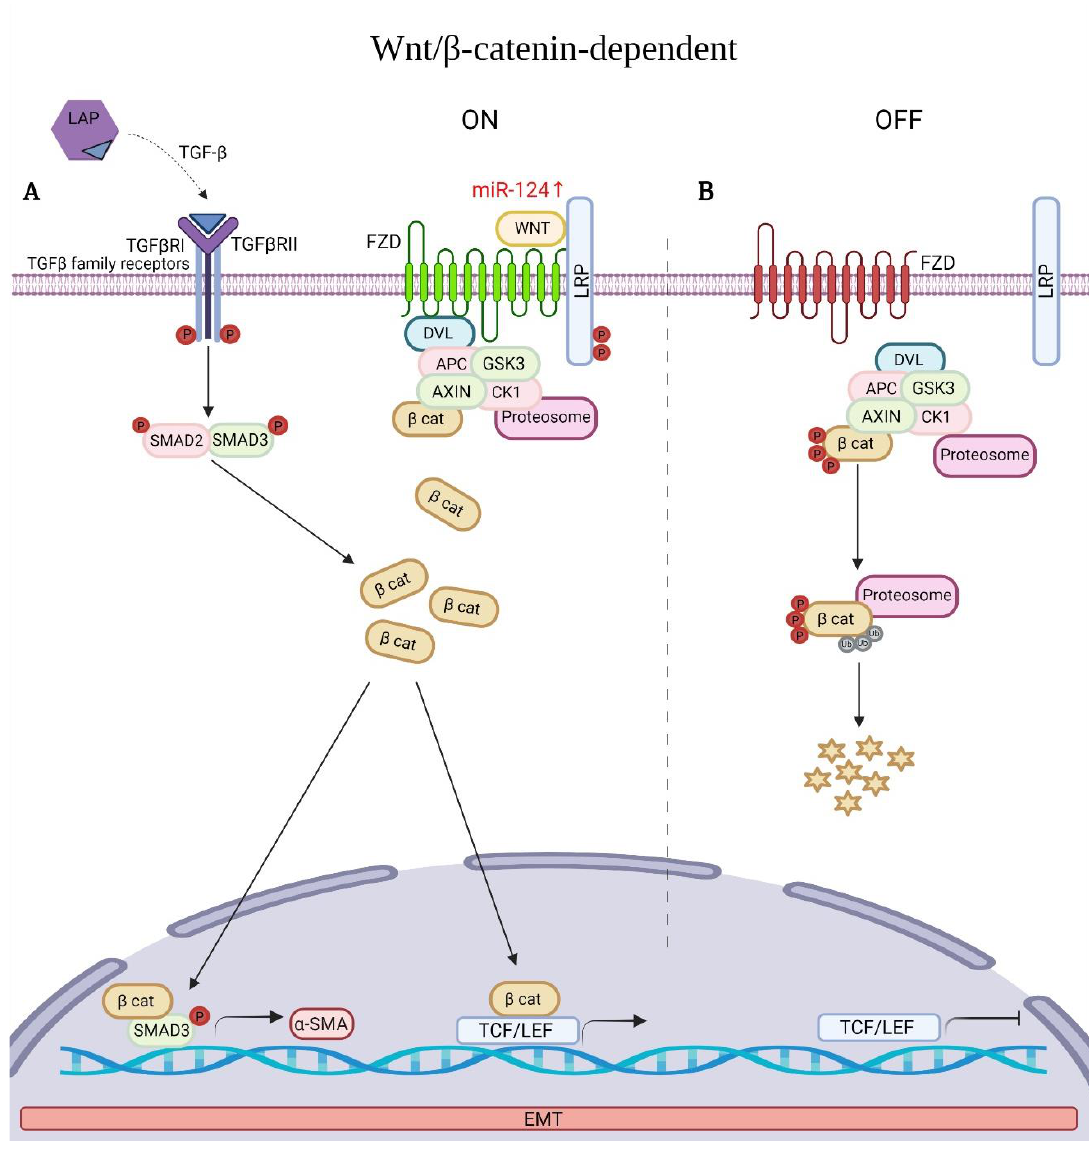
Figure 2. Wnt/β -catenin dependent signaling pathway and an example of associated miRNA (red) in Idiopathic Pulmonary Fibrosis (IPF). ( A ) The binding of Wnt to its receptors Frizzled (FZDs) and to phosphorylated lipoprotein receptor-related protein (LRP) leads to activation of the Wnt signaling pathway. β -catenin is stabilized and translocated in the nucleus, where it binds to T-cell factor/lymphoid enhancer factor- 1 (TCF/LEF) to upregulate target genes. TGFβ1 synergizes with nu- clear β -catenin regulating alfa-SMA expression. ( B ) In the absence of Wnt, β -catenin is degraded by the proteosome. Red color indicates upregulated miRNA, Stars repre sent byproducts of β -catenin degradation.